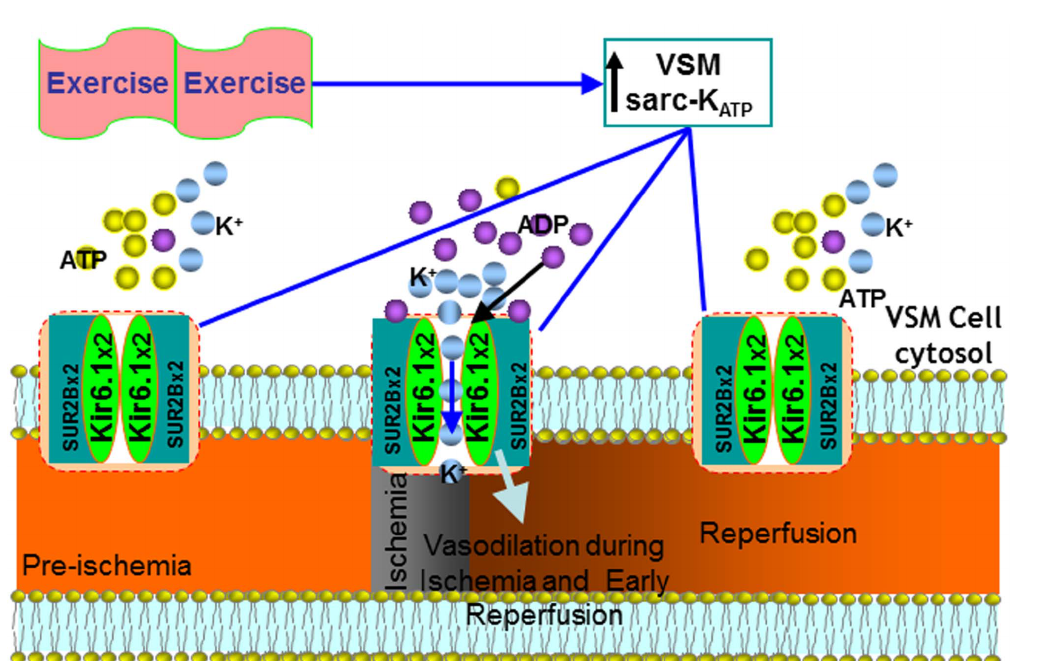
Figure 10. A schematic diagram of our hypothesis: endurance exercise up-regulates Kir6.1 and shortens tissue oxygenation recovery time. During ischemia and at the beginning of reperfusion, the relatively high level of the ADP/ATP opens the VSMC sarc-K ATP channels, leading to hyperpolarization of the VSMC membrane and dilation of the coronary vasculature. Kir6.1-induced transient vasodilation shortens reperfusion recovery time t and contributes to exercise-induced protection of myocytes from I/R